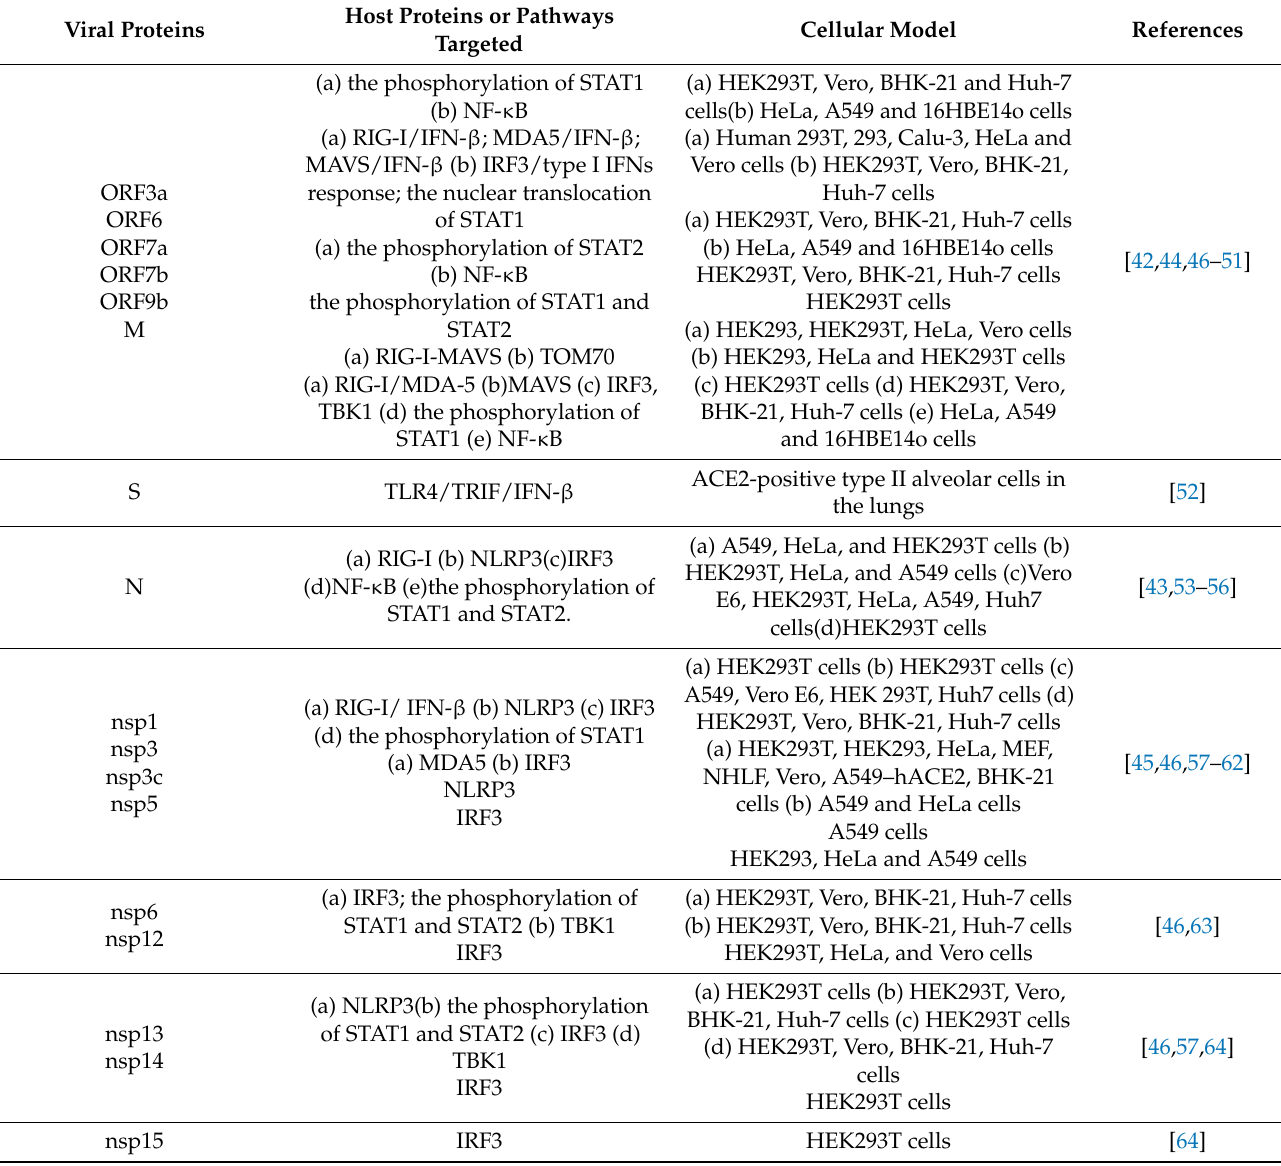
Table 1. Summary of targets of SARS-CoV-2 proteins or